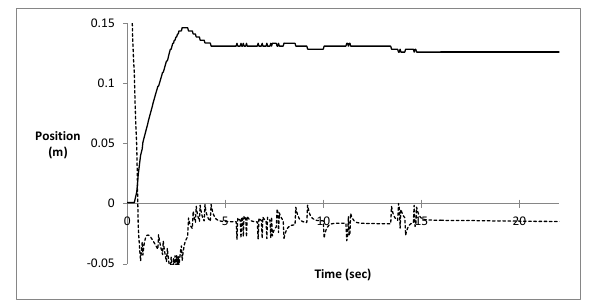
Figure 30: Step response for feedback‐linearized P‐D control